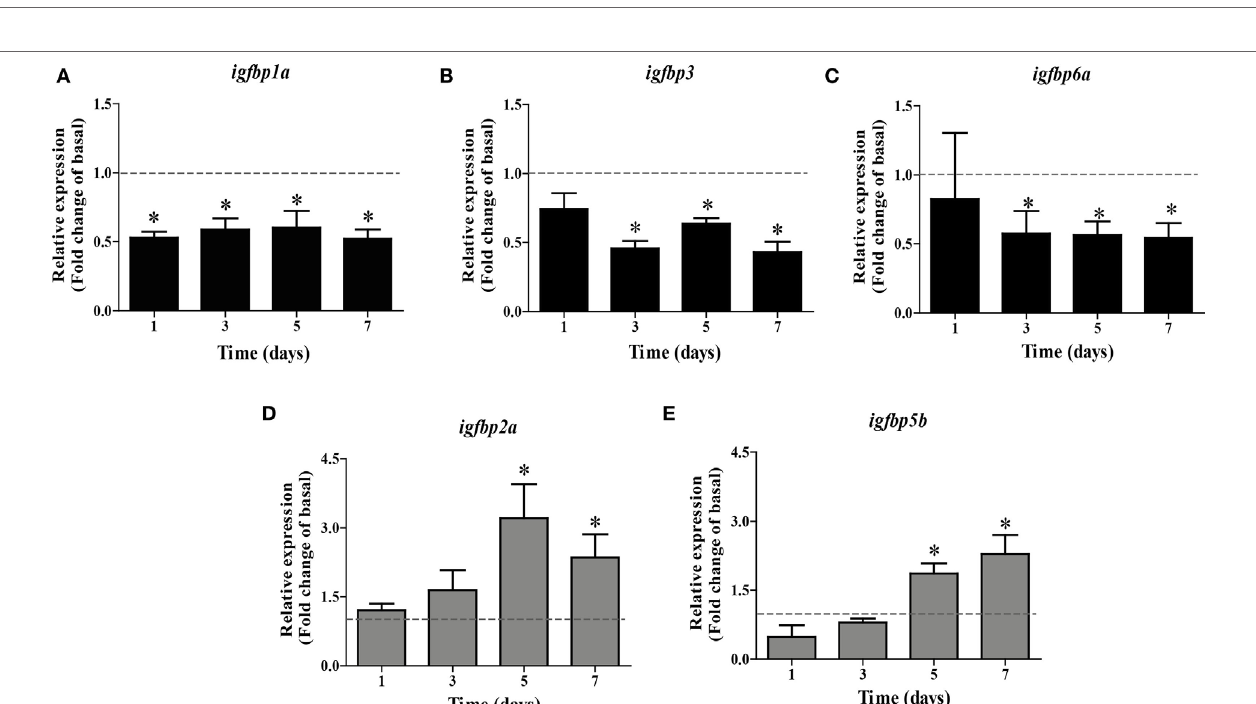
FigUre 2 | Follicle-stimulating hormone (Fsh) time-course study on igfbp transcript levels in adult zebrafish testis after 1–7 days of primary organ culture. Transcript levels of igfbp1a (a) , igfbp3 (b) , igfbp6a (c) , igfbp2a (D) , and igfbp5b (e) are expressed as fold-change compared to basal conditions (absence of Fsh; represented by a dotted line), as induced by recombinant zebrafish Fsh (100 ng/mL) (bars). The duration of the ex vivo culture varied between 1 and 7 days ( n = 5–7). Asterisks indicate significant differences (* P < 0.05) compared to the respective control